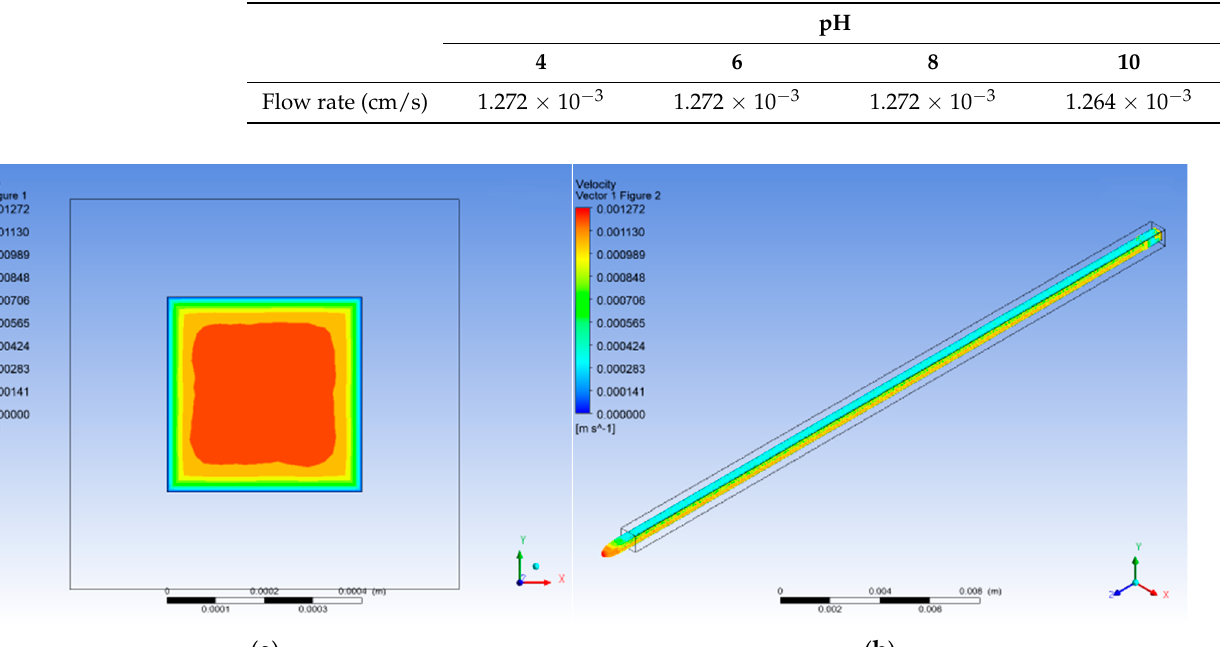
Table 3. CFD analysis result.